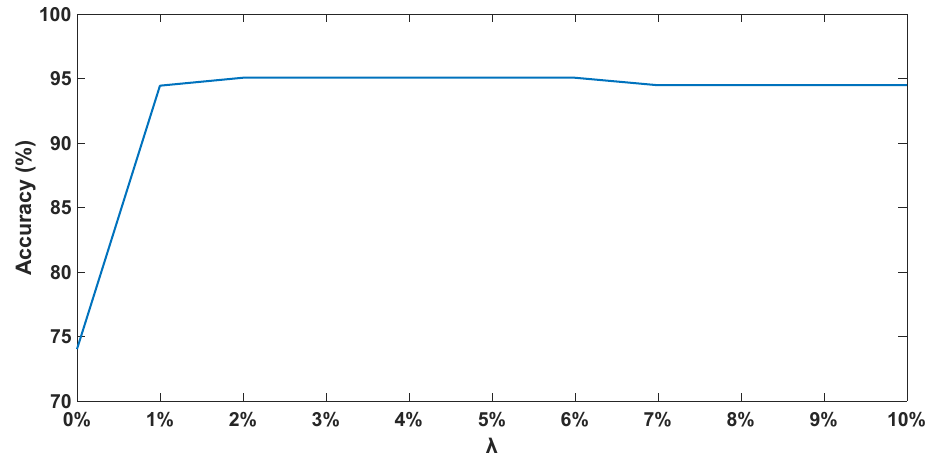
Figure 9. λ statistical analysis.